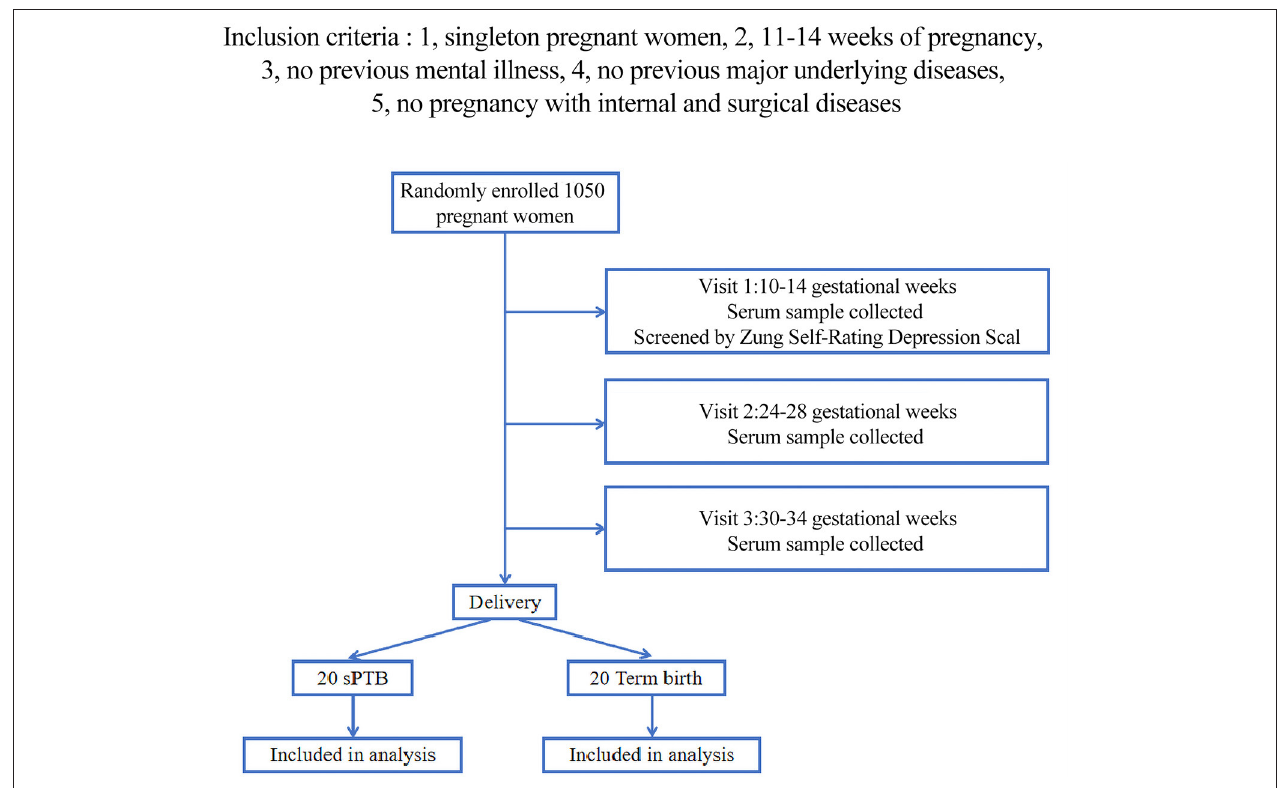
FIGURE 1 | The flow chart of our